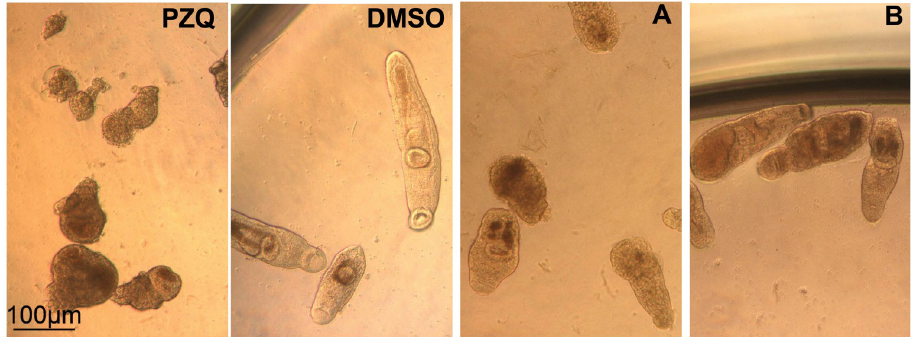
Fig 6. Schistosoma mansoni juveniles treated with PZQ: Praziquantel, DMSO: Dimethyl sulfoxide; A: Perhexiline, B: Astemizole at 24 hours (h). PZQ and compounds were tested at 30 μ M and DMSO at 0.3% v/v. Images were taken at 10x magnification. DMSO: Dimethyl sulfoxide; v/v: volume by volume.